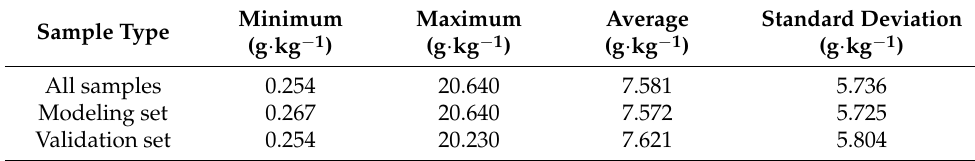
Table 3. Descriptive statistics of soil samples.